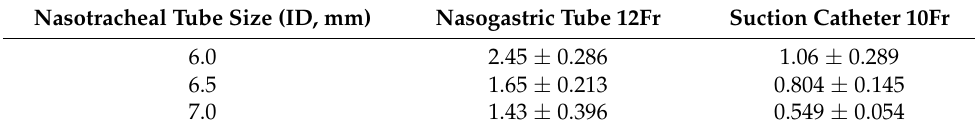
Table 3. The force when removing the